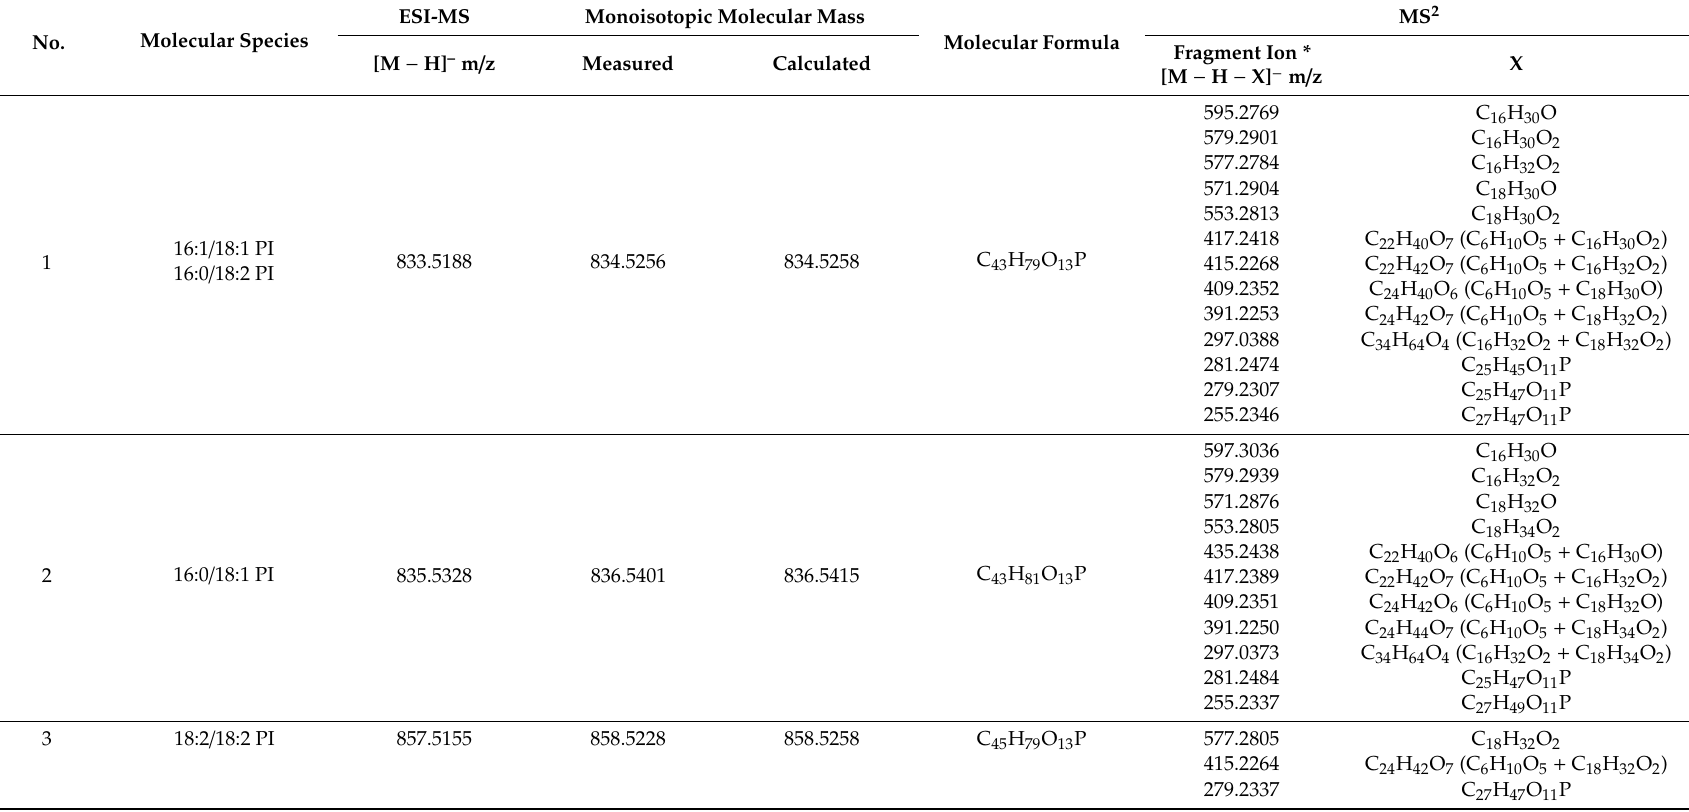
Table 5. Molecular species of phosphatidylinositol (PI) from Madhuca ellitica